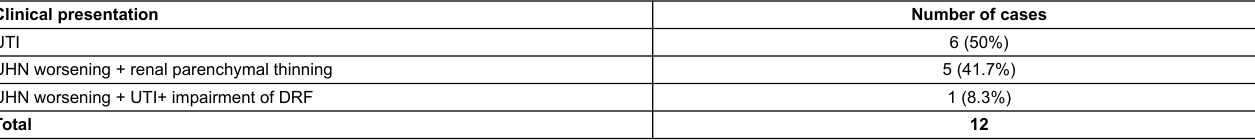
Table 1: Indications for surgical treatment (high-pressure balloon